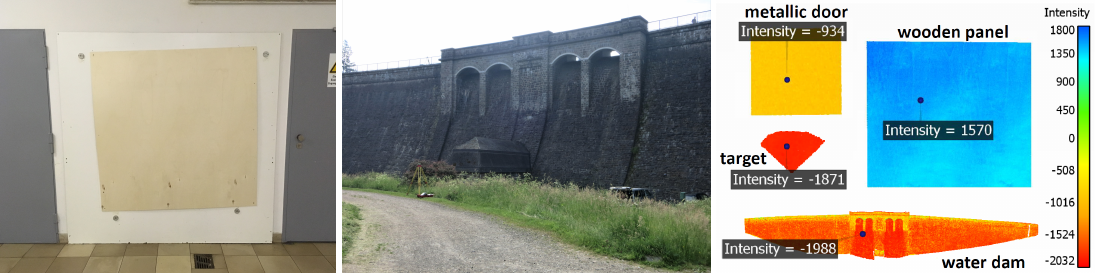
Figure 1. Two examples from practice [3]. Left : Wooden Panel; Middle : water dam; Right : Point clouds with intensity